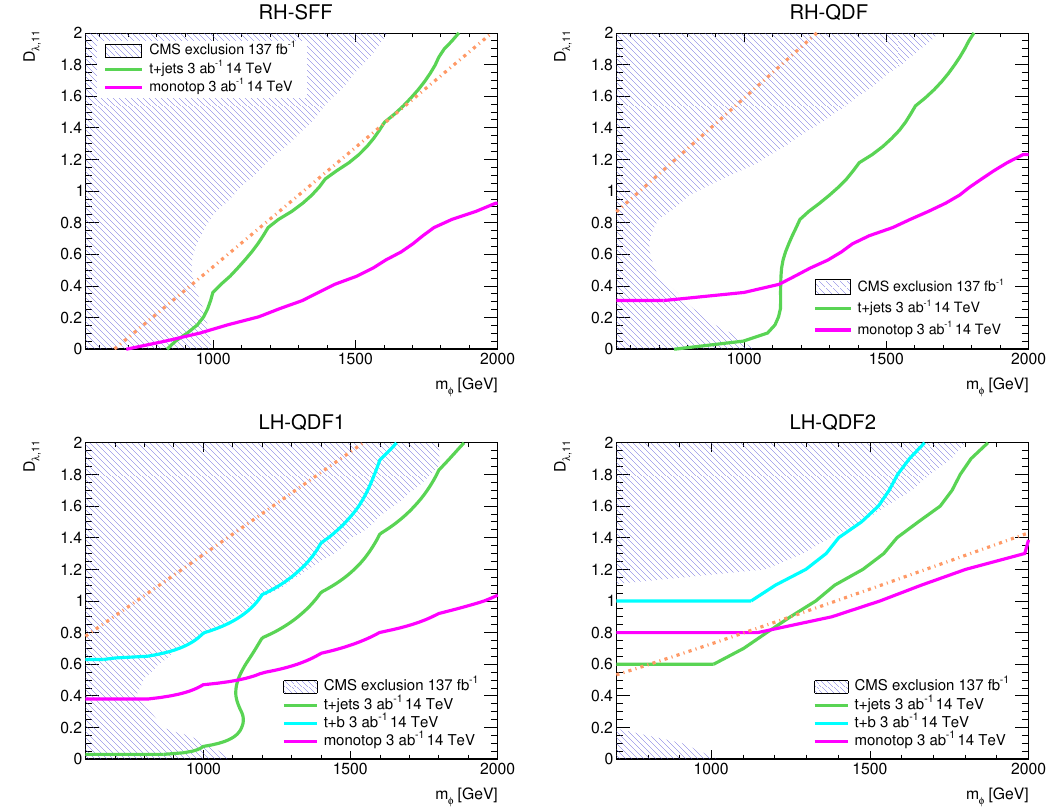
Figure 14 . Excluded areas in the ( m φ , D λ, 11 ) plane for the tj , tb and monotop analyses proposed in this paper for an integrated luminosity of 3 ab − 1 at a 14 TeV LHC. The excluded areas are on the left of the curves. The shaded area corresponds to the region excluded by the CMS analyses. The orange dash-dotted lines indicate for which set of parameters the correct relic abundance is